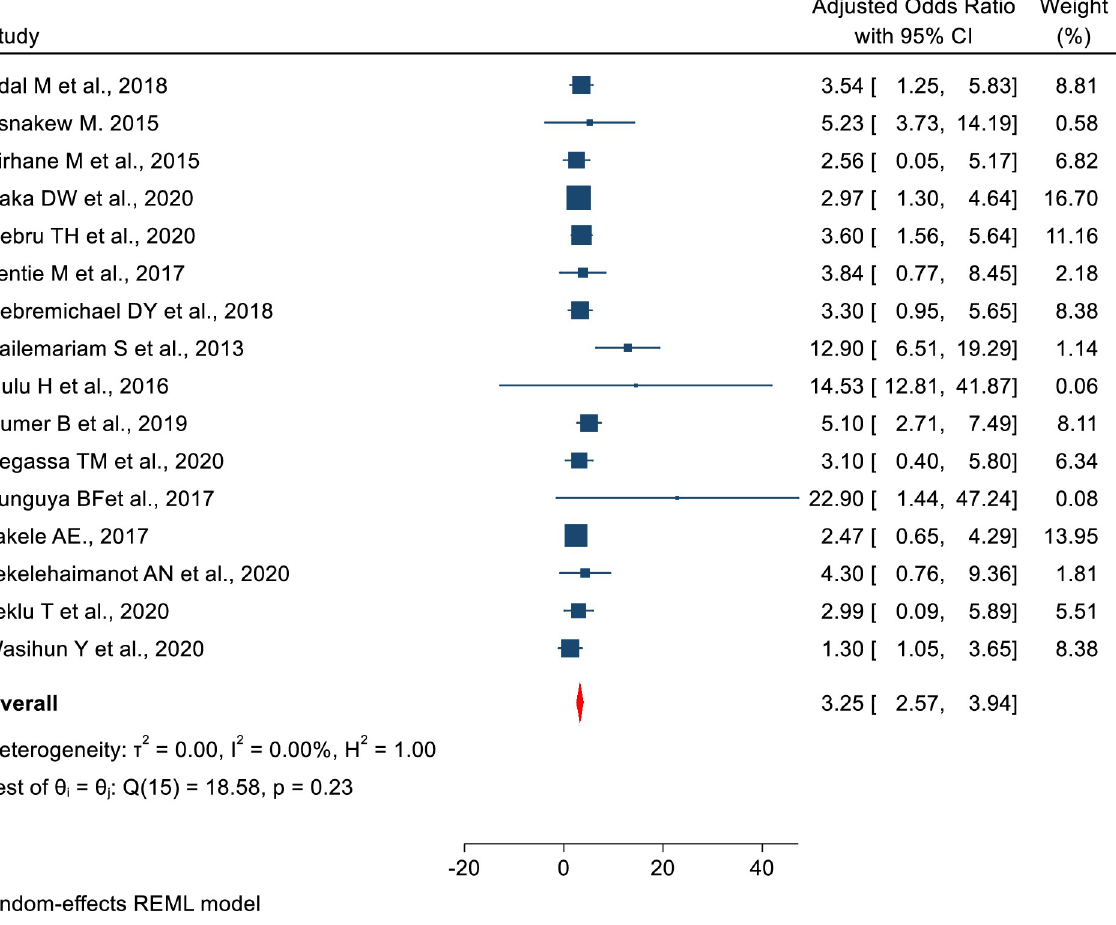
Fig 4. The pooled effect of “WHO clinical stage” on undernutrition among adult PLWHIV in sub-Saharan Africa, 2021.